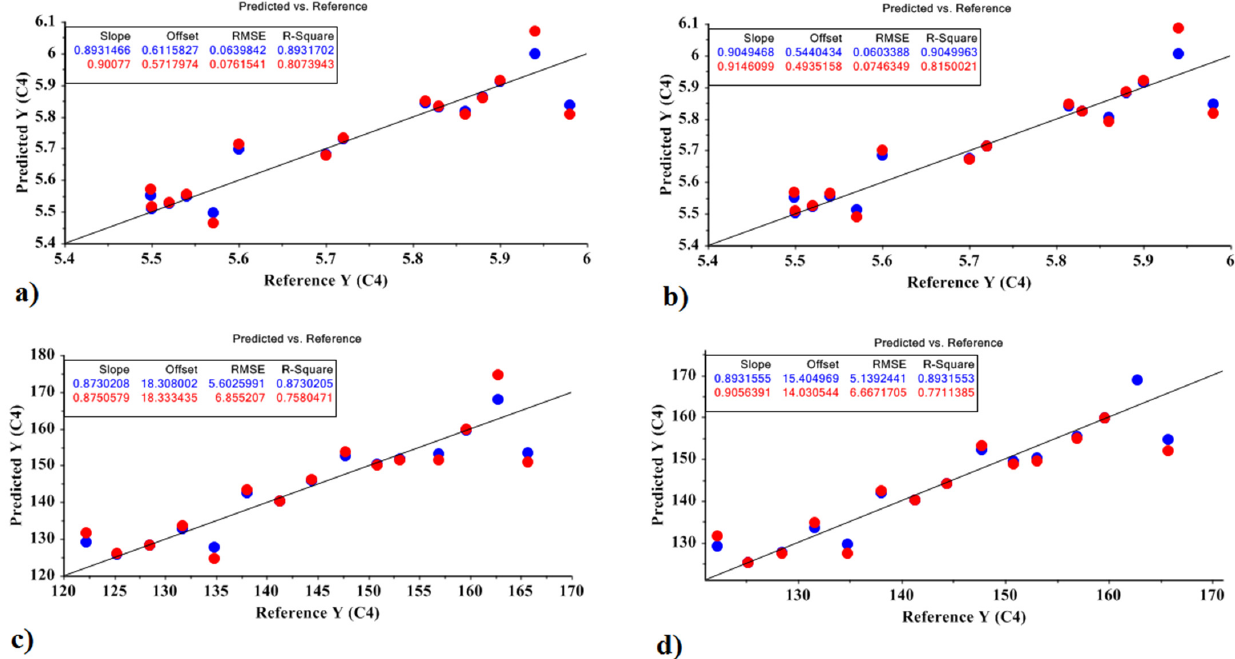
Figure 3. MLR prediction models for predicting the amount of carbohydrate and sugar in the Sprit cultivar: ( a ) the amount of sugar based on the PCR method; ( b ) the amount of sugar based on the PLSR method; ( c ) the amount of carbohydrate based on the PCR method; ( d ) the amount of carbohydrate based on the PLSR method.